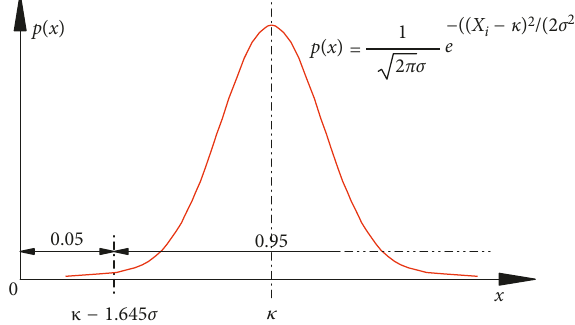
Figure 4: Layout of reinforcing mesh and measurement points of shaft lining model.